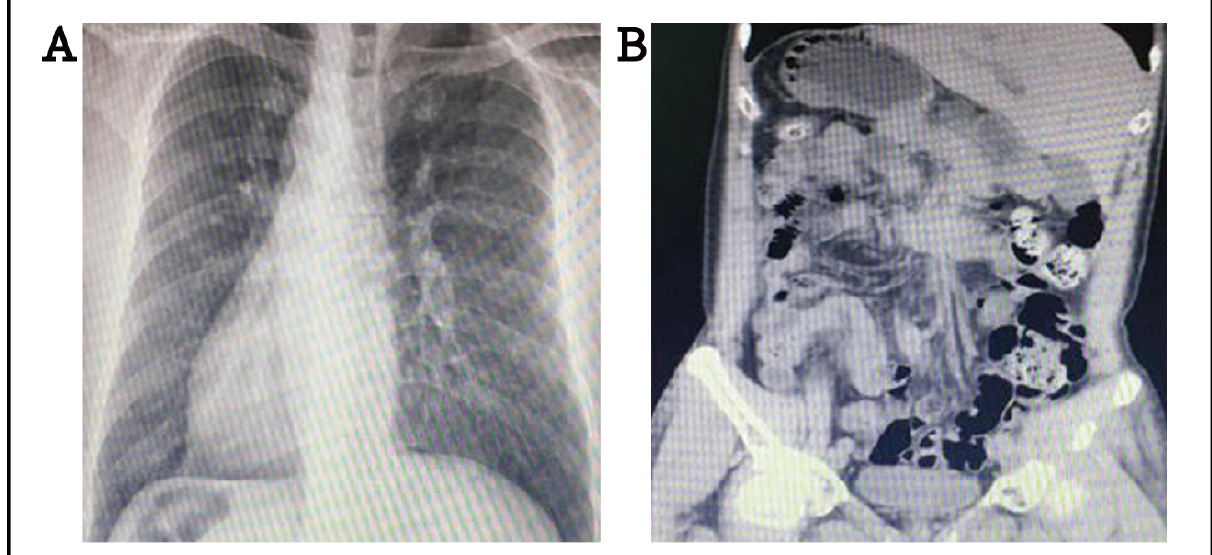
Figure 1: ( A ) Chest X-ray showing dextrocardia with a right aortic arch, right-sided stomach air bubble; ( B ) coronal CT scan showing the com- plete situs inversus. CT: computed tomography.